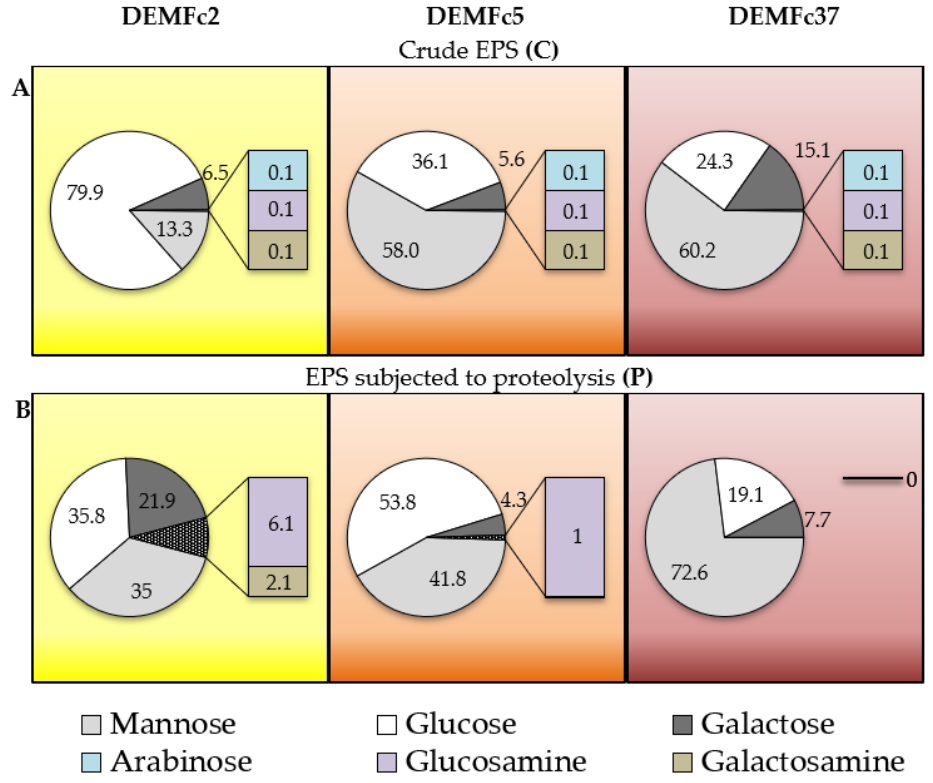
Figure 12. Percentage (%) content of sugar monomers (mannose, glucose, galactose, arabinose, glucosamine and galactosamine) in: ( A ) crude EPS (C) and ( B ) proteolysed (P) EPS obtained from cultures of three F. culmorum strains: DEMFc2, DEMFc5, and DEMFc37.